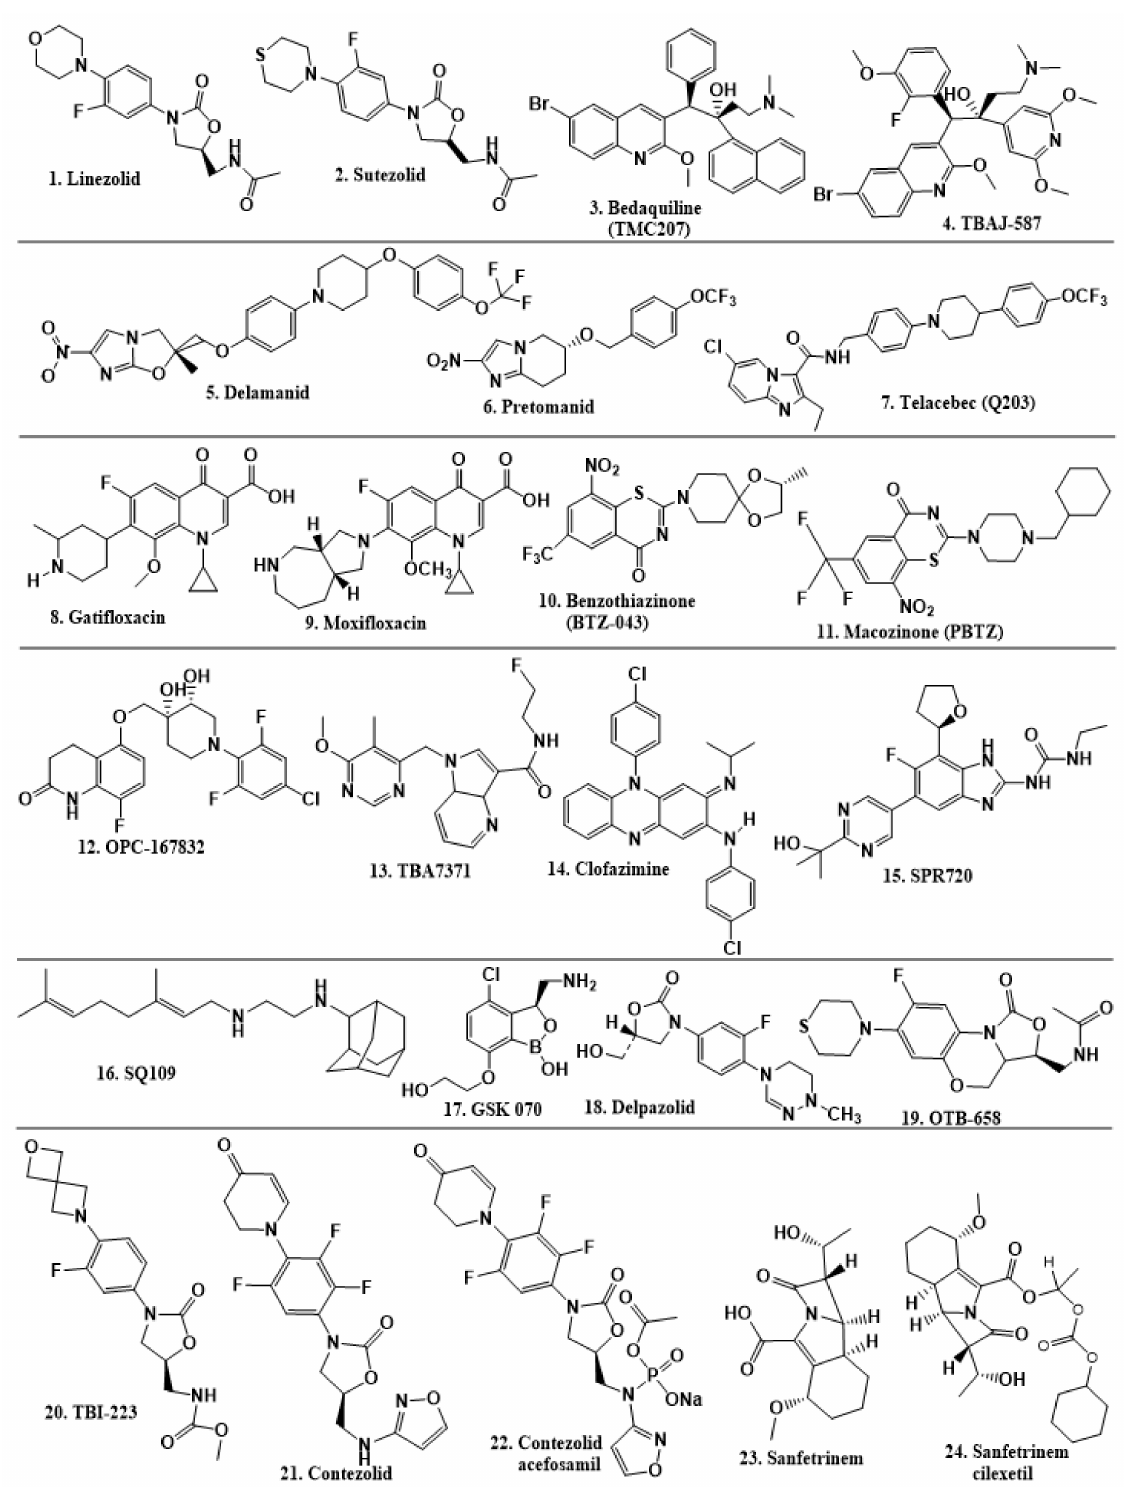
Figure 5. Chemical structures of new Mtb drugs at different clinical trial